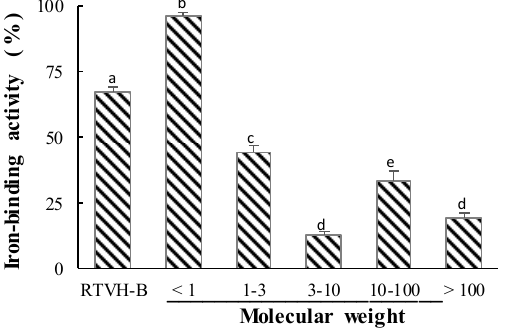
Figure 3. Iron-binding activity of RTVH-B and its molecular weight fractions. Values are expressed as means ± standard deviation ( n = 4). Different superscript letters (a–d) denote statistically significant differences among treatments ( p < 0.05).